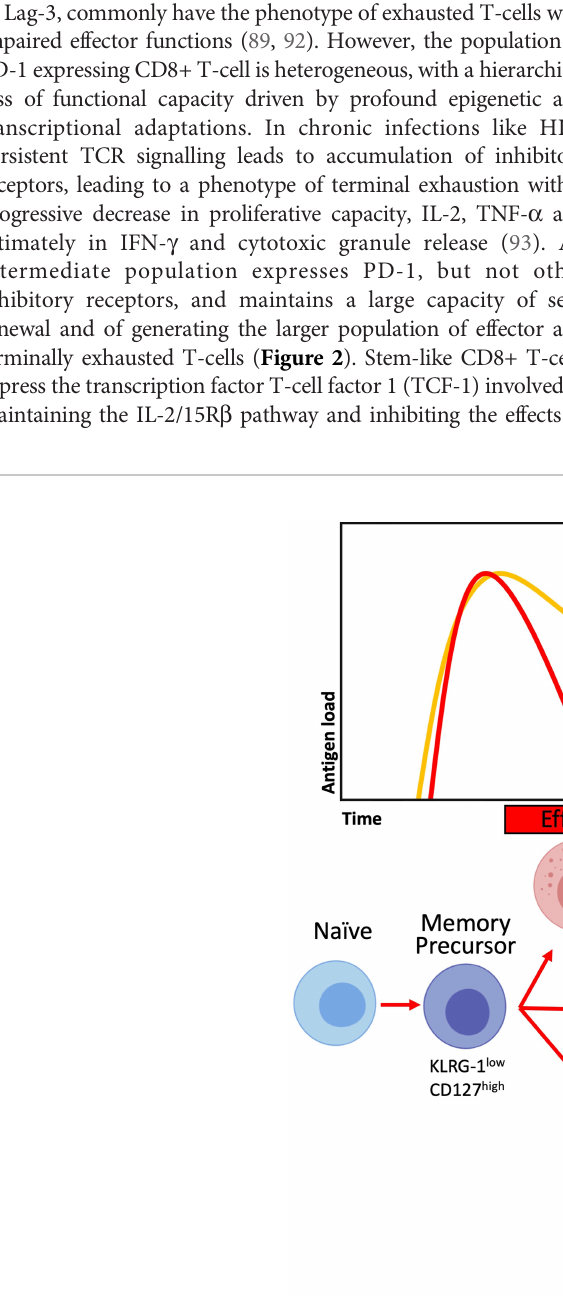
FIGURE 2 | T-cell differentiation in the context of acute (red) and chronic (yellow) infections. Activated T-cells differentiate into Memory precursors cells, giving rise to Effector cells capable of controlling antigen load. In the contraction phase, most Effector cells die, while a proportion will differentiate into Memory cells. In the context of chronic antigen load, Memory precursor cells differentiate into Early Exhausted T-cells with intermediate levels of PD-1 expression and high expression of TCF-1 while retaining their capacity for self-renewal. The chronic presence of antigen leads to the differentiation of Early Exhausted cells into Terminally Exhausted with progressively decreased effector and self-renewal capacity while increasing the expression of inhibitory receptors, including PD-1, Tim-3 and